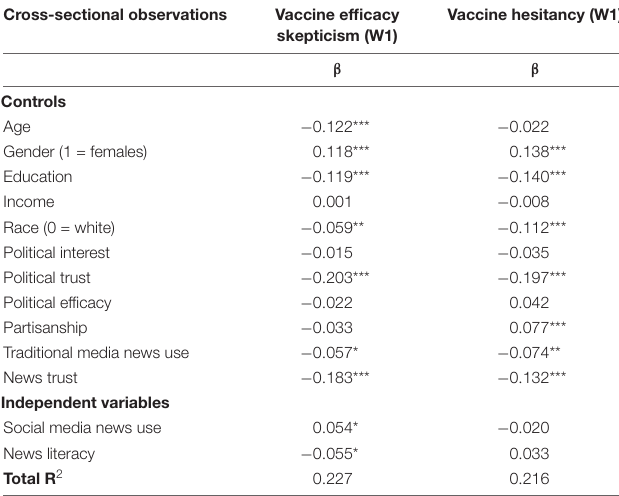
TABLE 1 | Predicting skepticism regarding vaccine efficacy and vaccine hesitancy (cross-sectional observations). a Cross-sectional